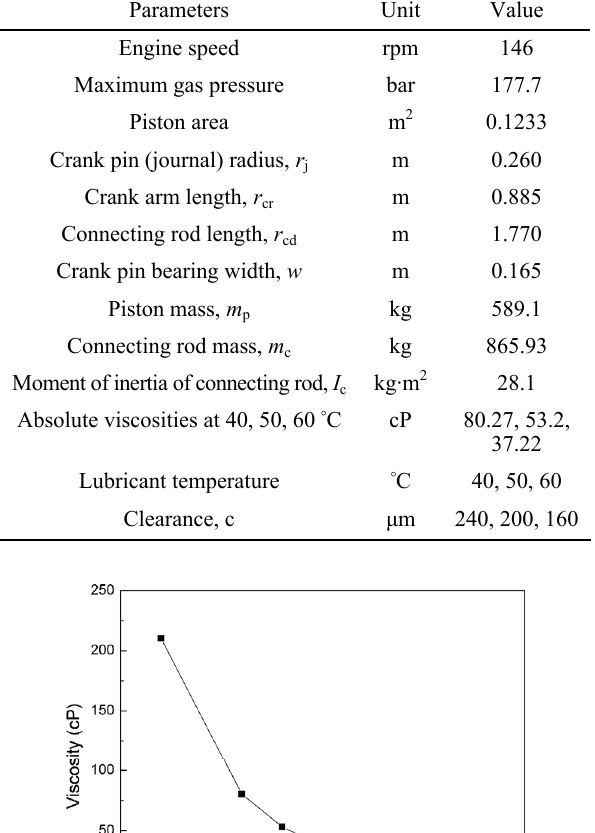
Table 1 Specifications of the large end-connecting rod bearing and operation conditions.